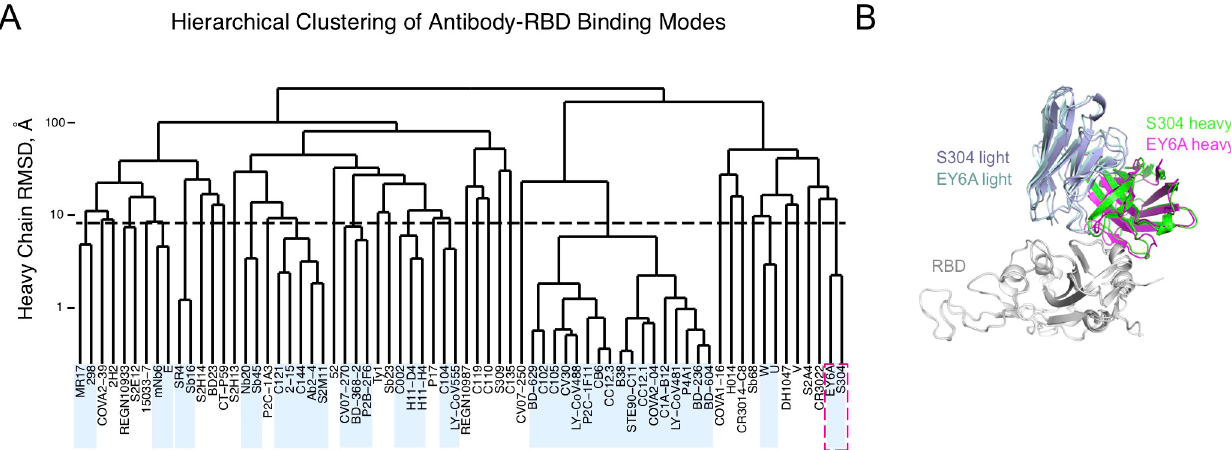
Fig 1. Hierarchical clustering of SARS-CoV-2 RBD antibody binding modes. (A) Pairwise root mean square distances (RMSDs) between heavy chain or nanobody binding orientations were determined for 70 antibody-RBD complex structures and used to perform hierarchical clustering. Boxes denote clusters containing multiple antibodies at distance cutoff of 8 Å (shown as dashed horizontal black line), and dashed magenta square denotes co-clustered structures shown in panel (B). (B) Example of co-clustered antibodies S304 (PDB code 7JX3) [21] and EY6A (PDB code 6ZCZ) [22] with a shared RBD binding mode (2.2 Å heavy chain orientation RMSD). Structures are superposed by RBD (gray), and S304 and EY6A heavy and light chains are colored separately as indicated.